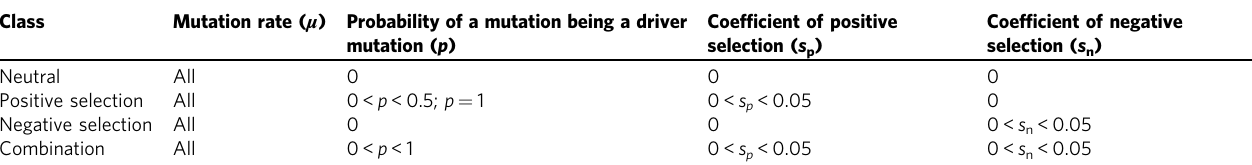
Table 1 Parameter ranges used to generate evolutionary